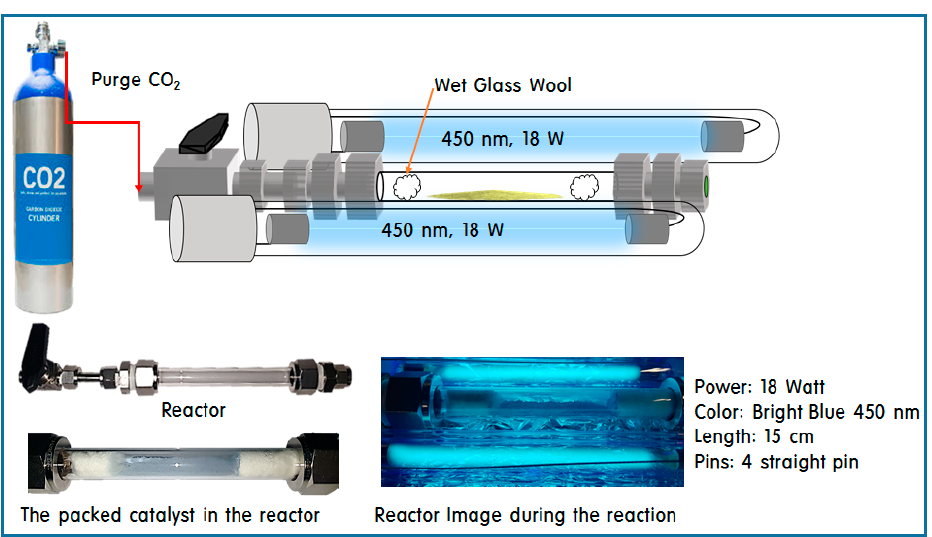
Figure 11. Configuration and schematic of CO 2 photoreduction reactor.